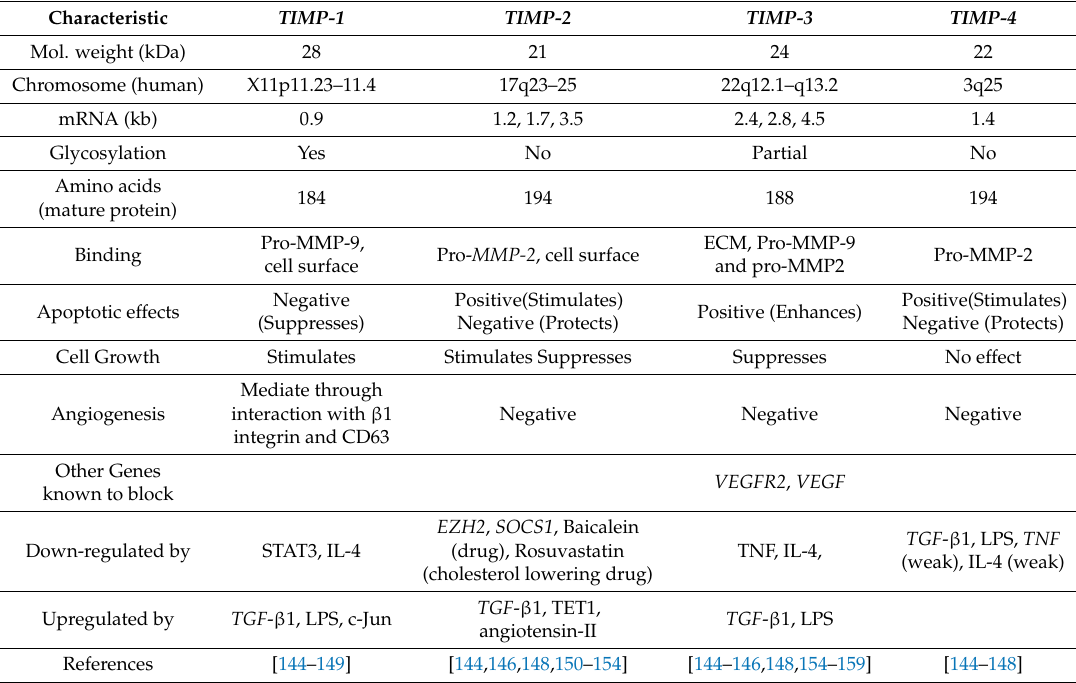
Table 2. Characteristics of tissue inhibitors of matrix